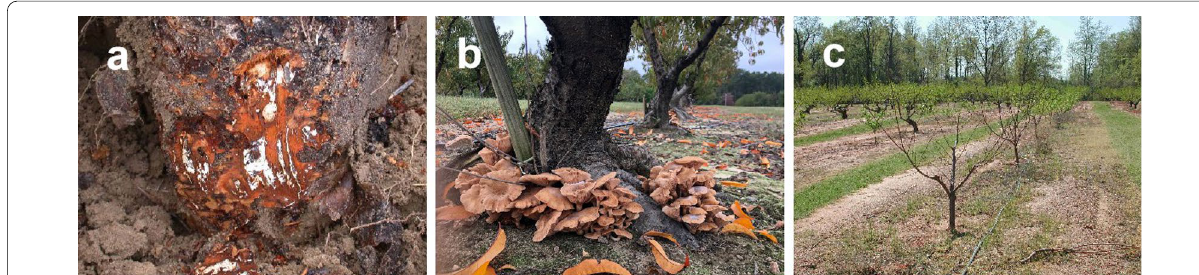
Fig. 3 Symptoms and signs of Armillaria root rot. a Mycelial fans on cut bark from affected lower trunk tissue (South Carolina, 2015). b Mushroom clusters of D. tabescens produced from diseased roots and crown (South Carolina, 2020). c Within tree row spread of the disease due to root‑to‑root contact leading to complete tree collapse (South Carolina, 2015)